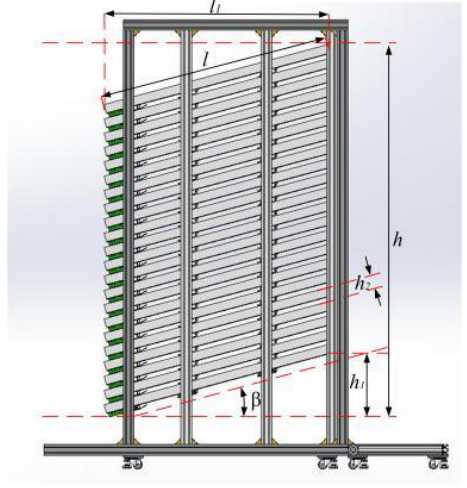
Figure 4. Side view of drug storage tank.